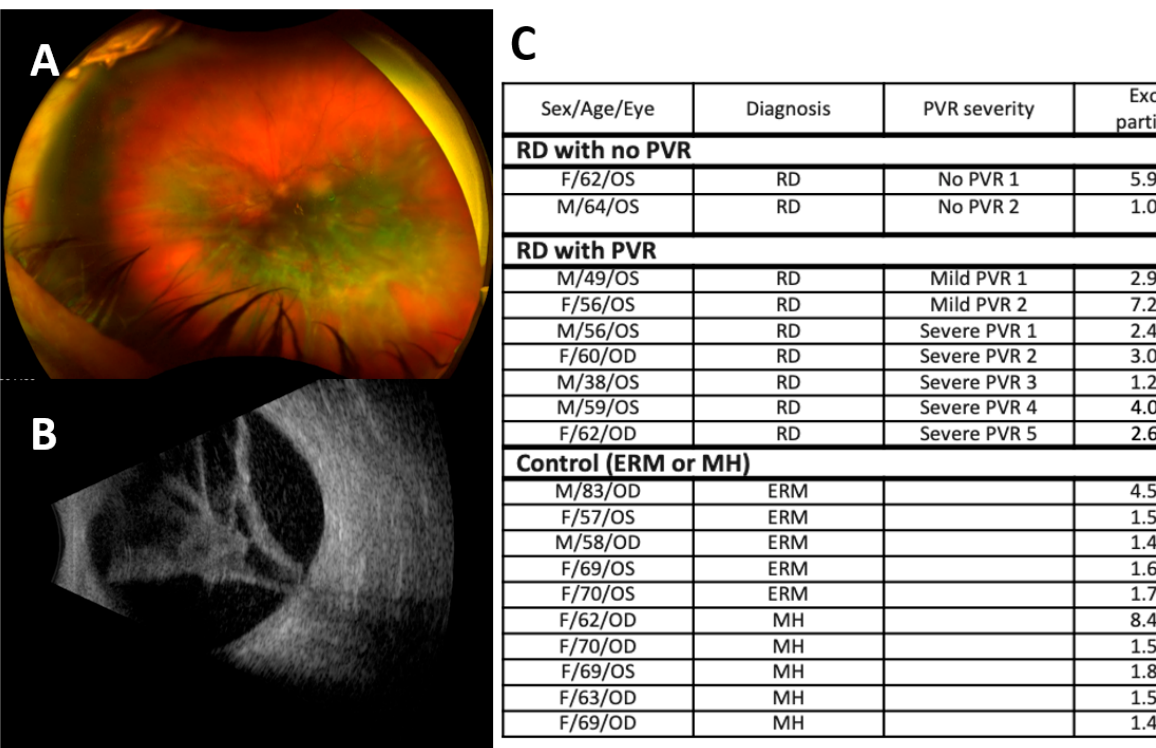
Figure 1. Clinical findings in severe proliferative vitreoretinopathy (PVR) and patient demographics. ( A ) Fundus image and ( B ) B-scan of severe PVR demonstrating vitreous opacity, star folds, and fibrous proliferation that led to closed tractional retinal detachment. ( C ) Patient demographics. RD, retinal detachment; PVR, proliferative vitreoretinopathy; ERM, epiretinal membrane; MH, macular hole